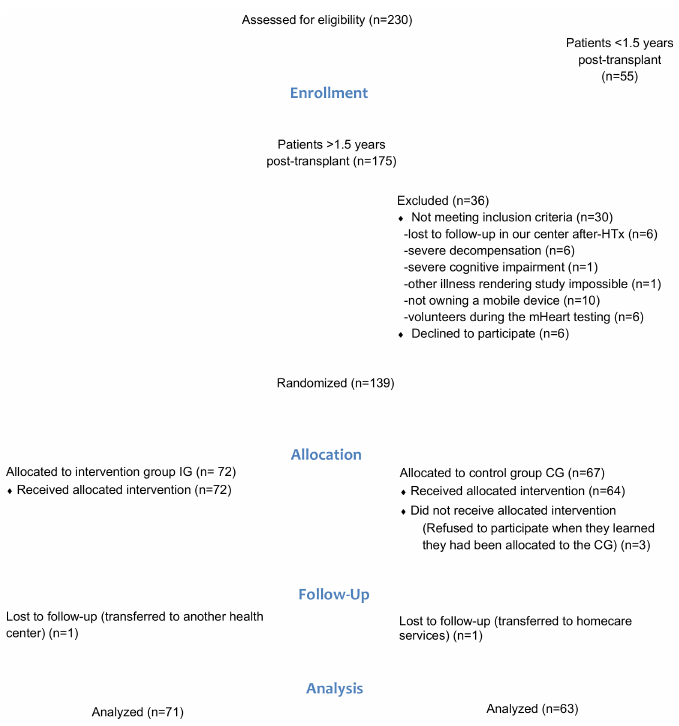
Figure 4. Patient flow chart according to the CONSORT